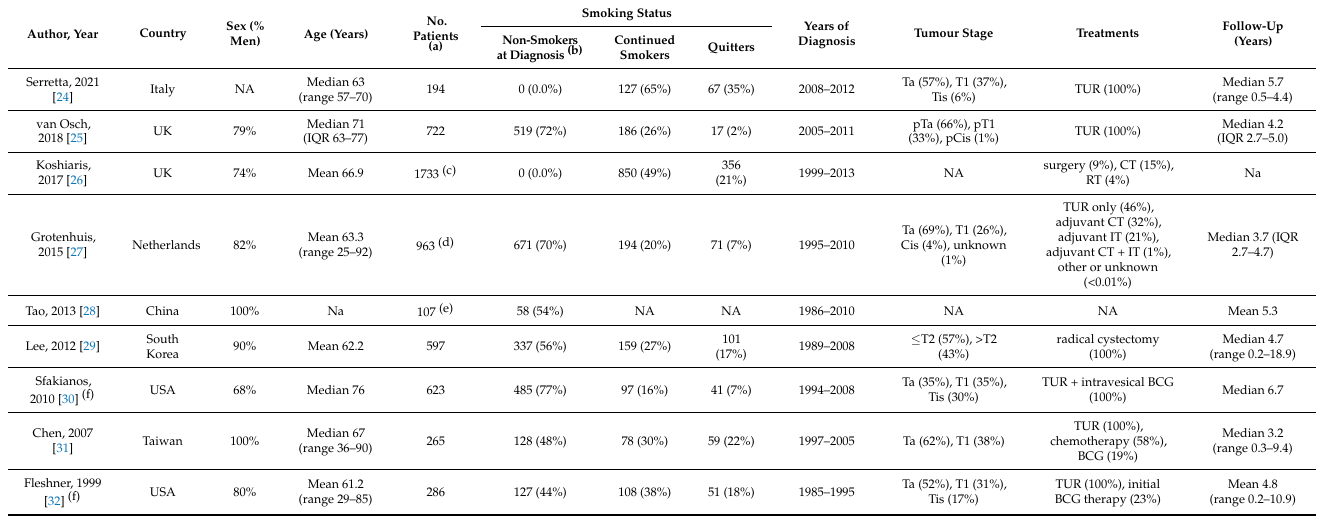
Table 1. Main characteristics of the studies included in the systematic review and meta-analysis on the prognostic effect of quitting smoking at or around diagnosis on the survival of bladder cancer patients.